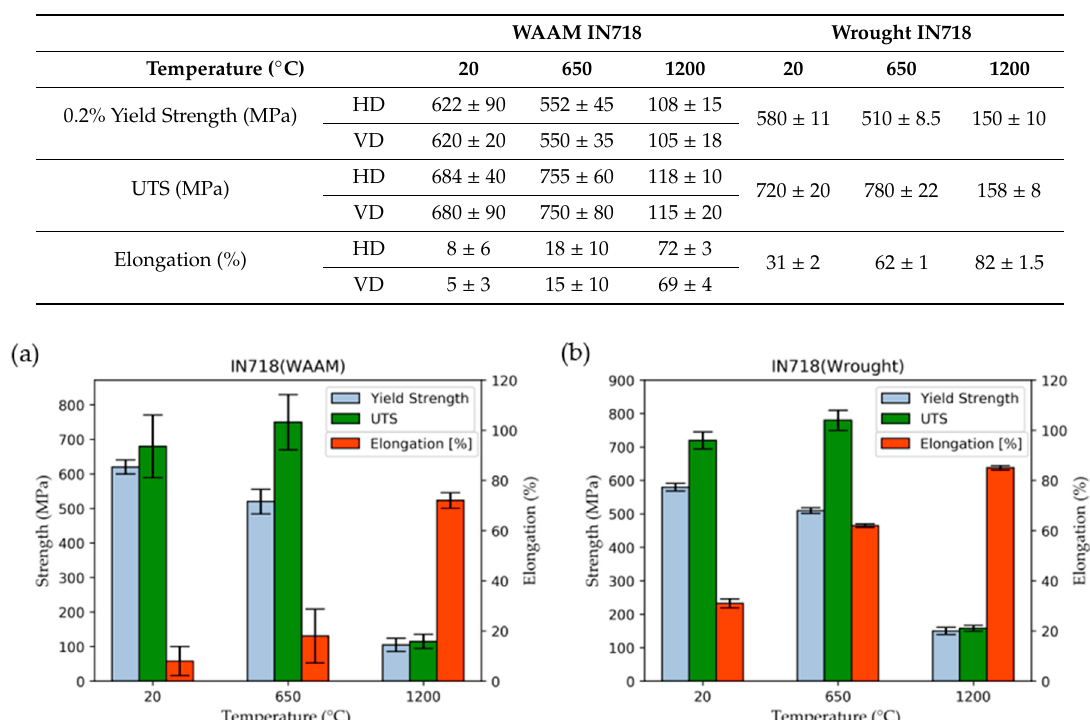
Figure 9. Mechanical properties of ( a ) WAAM ( b ) Wrought IN718 alloy at various